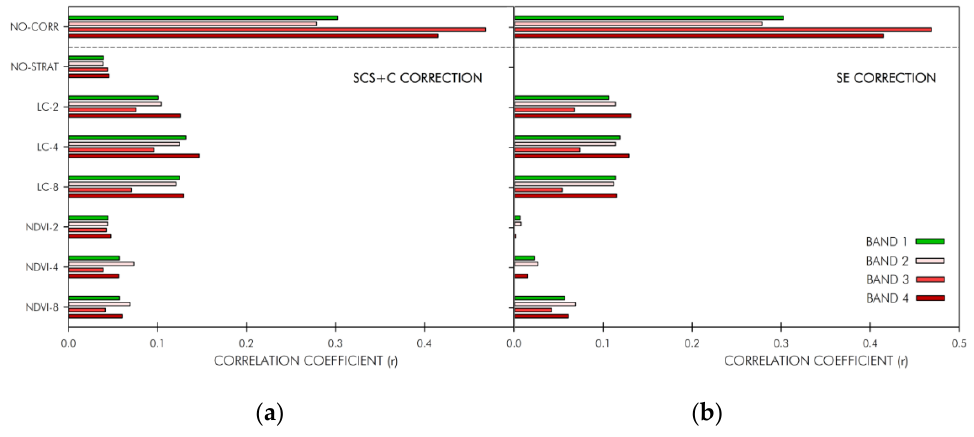
Figure 6. Correlation coefficient of the regression between cos γ i and the reflectance of each spectral band for the uncorrected image (NO-CORR.) and the different strategies tested on SCS + C correction ( a ) and SE correction ( b ).